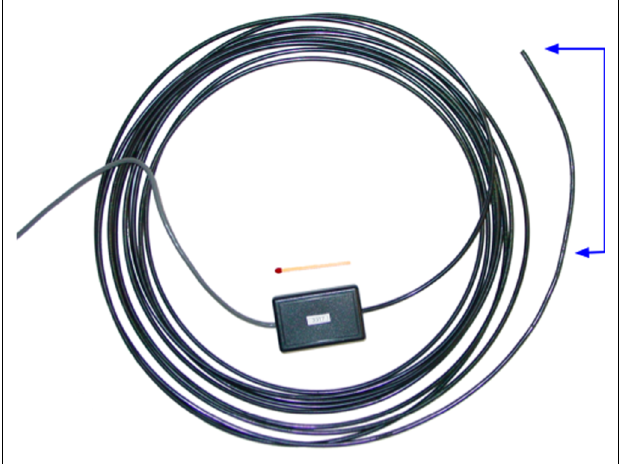
FIGURE 1 | The fi ber-optic bend sensor to monitor jaw movements. The active zone of the sensor (right, indicated in blue) is attached to the participant’s chin. The electronics (middle) are located outside the magnet room and consist of an LED and two photodiodes for transmission and detection of the light, respectively. A matchstick is shown for scale.